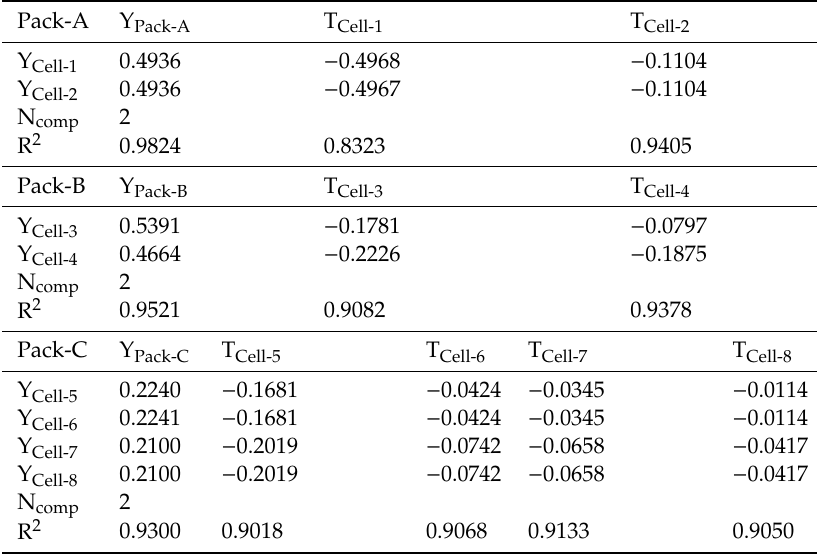
Table 8. Unbalanced model normalization coe ffi